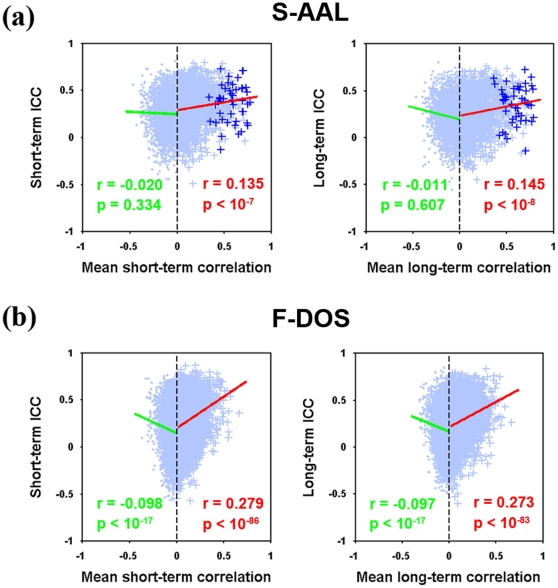
Relationship between RSFC and TRT reliability.Scatter plots of mean connectivity strength against corresponding ICC values are depicted to show the relationship for both S-AAL (a) and F-DOS (b) based correlation matrices. The trend lines were obtained by linear least-square fit. Significant (p<0.05) positive correlations were found between positive RSFC and their corresponding ICC values for both ROIs sets and for both short-term and long-term scanning. In addition, significant negative correlations were also found for negative RSFC with their corresponding ICC values but only for F-DOS-based correlation matrices. These findings suggest higher reliability for stronger RSFC. Functional connections linking inter-hemisphere homotopic regions are highlighted by plus signs (+) for S-AAL but not for F-DOS because of the absence of direct correspondence. RSFC, resting-state functional connectivity; TRT, test-retest; S-AAL, structural ROIs from Anatomical Automatic Labeling atlas; F-DOS, functional ROIs from Dosenbach et al. (2006, 2010).